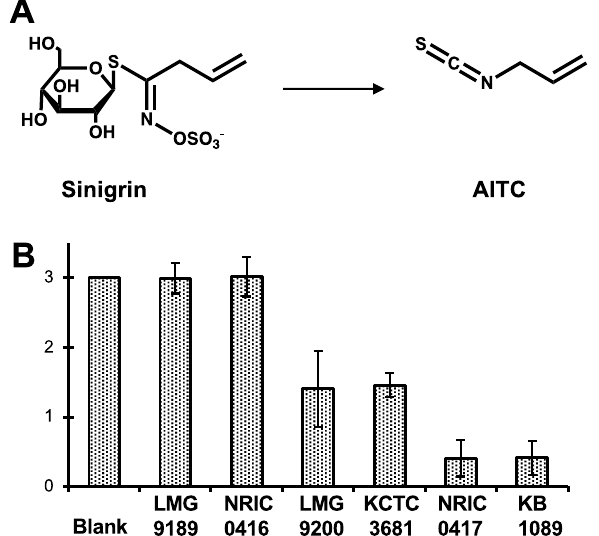
Figure 1. Screening of glucosinolate (GSL)-degrading lactic acid bacteria. ( A ) Structures of the substrate (sinigrin) and product (allyl isothiocyanate, AITC). ( B ) Amounts of residual sinigrin in the culture medium (initial sinigrin; 3.0 mM) after 24 h of cultivation of each strain of Cb. farciminis . Blank indicates the uninoculated sample. Data represent mean values (n = 3). Error bars indicate 95% confidence interval